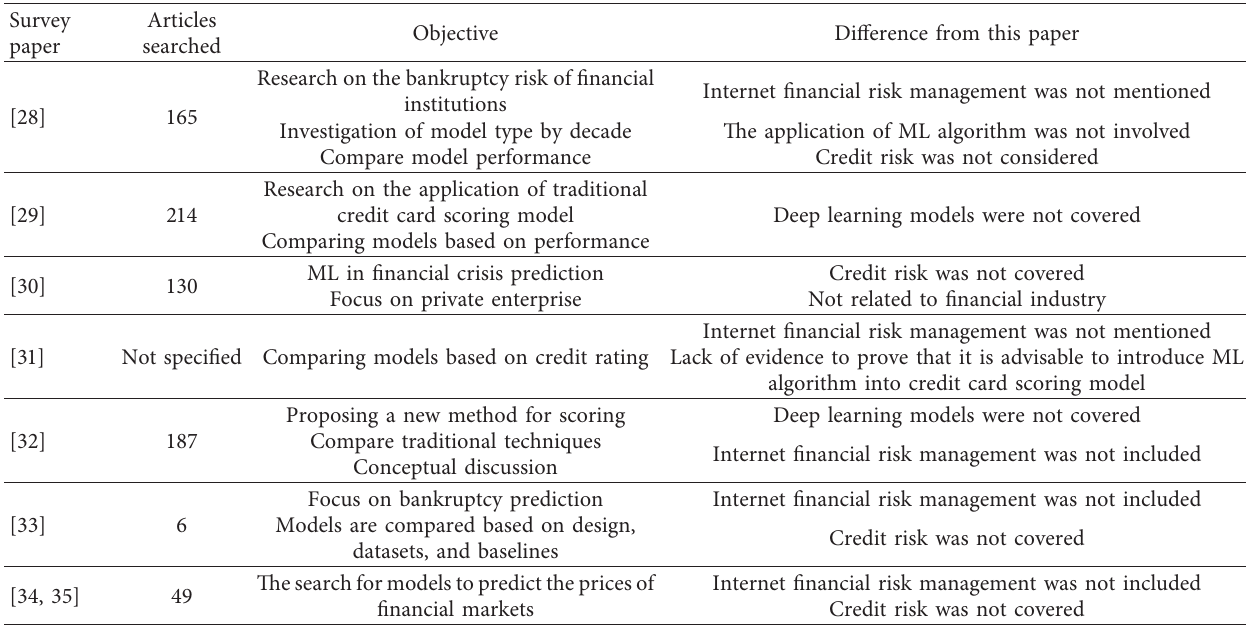
Table 1: Existing literature surveys on financial risk management and their differences from this survey paper.